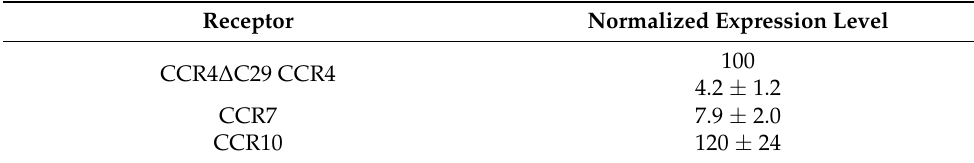
Table 2. Expression levels (%) of chemokine receptors CCR4, CCR7 and CCR10 in CHO cells 1 . Receptor